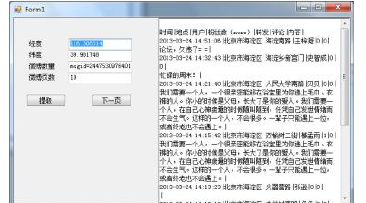
Figure 9. A tool for retrieving messages from microblog